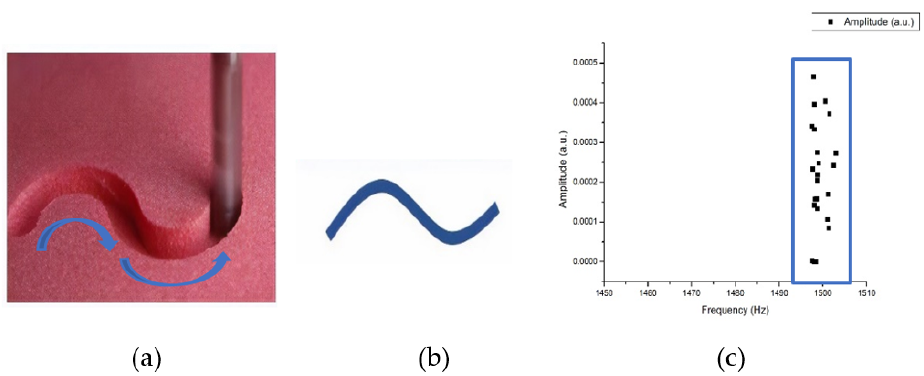
Figure 17. ( a ) Operation sketch, ( b ) trajectory of tool, ( c ) frequency of milling process for Styrofoam material.